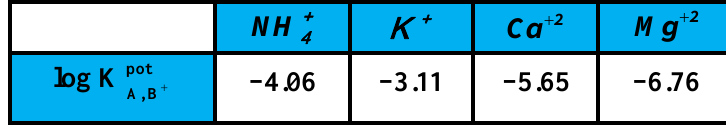
Table 1. Selectivity coefficients of Na + - selective electrode by Separate Solution Method (E